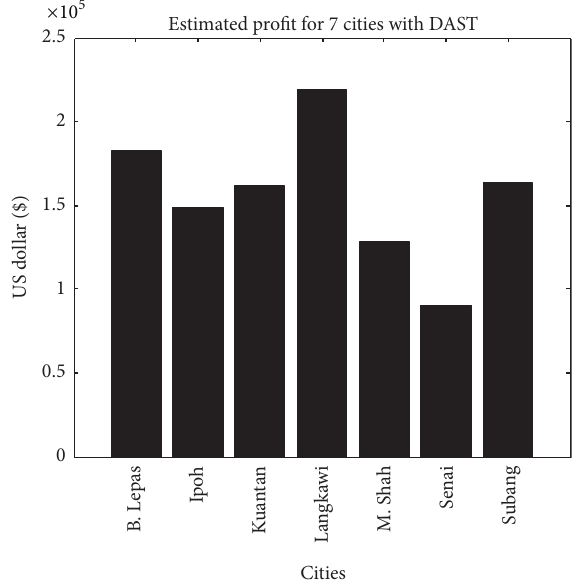
Figure 17: Estimated additional financial gain for seven cities with